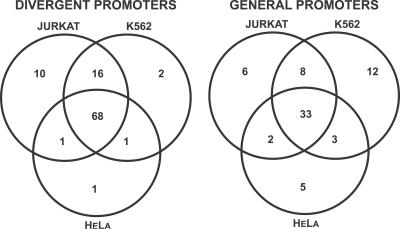
Venn Diagrams Showing the Overlap between GABP-Bound Divergent and General Promoters across Three Cell TypesThe number of promoters bound in K562 and Jurkat was larger than the intersections of either cell type and HeLa for both promoter classes. The majority of divergent promoters and a smaller fraction of general promoters were bound in all three cell types. The percentage of promoters bound in only a single cell type was larger for general promoters than for divergent promoters. Binding was significantly less cell type specific at divergent promoters.